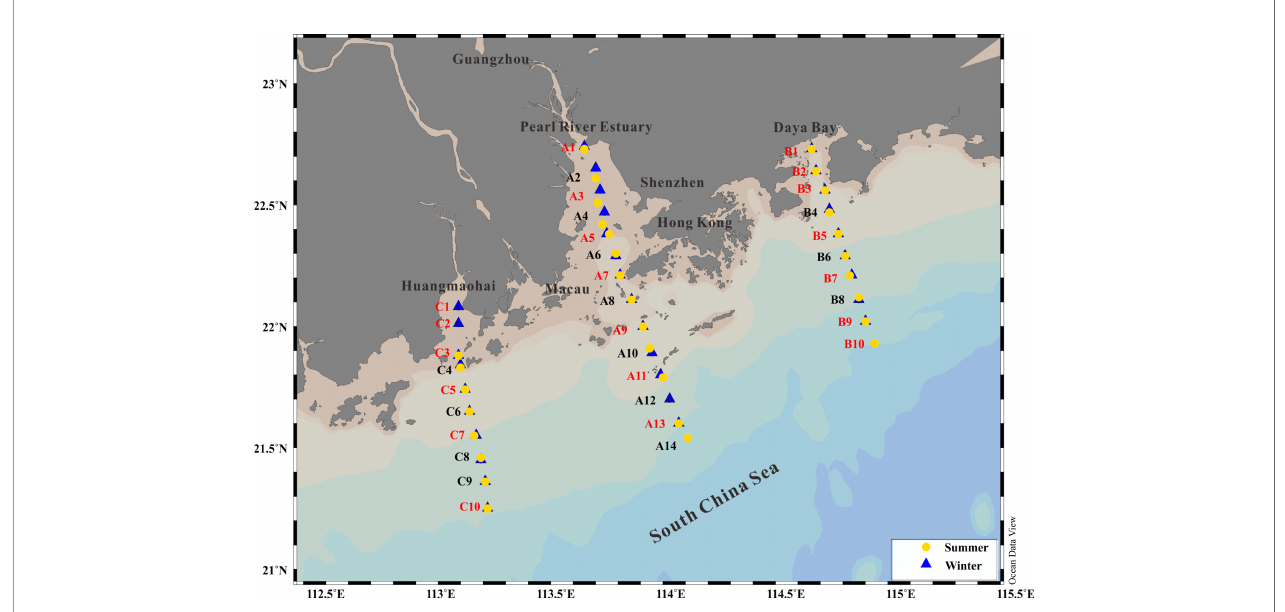
FIGURE 1 | Map indicating the sampling stations during the summer (yellow dots; July 14 – 24, 2019) and winter periods (blue triangles; December 8 – 18, 2020). Stations marked in red show where the cell size-fractionated Chl a measurements and metabolic experiments (GPP, CR, and NCP) were carried